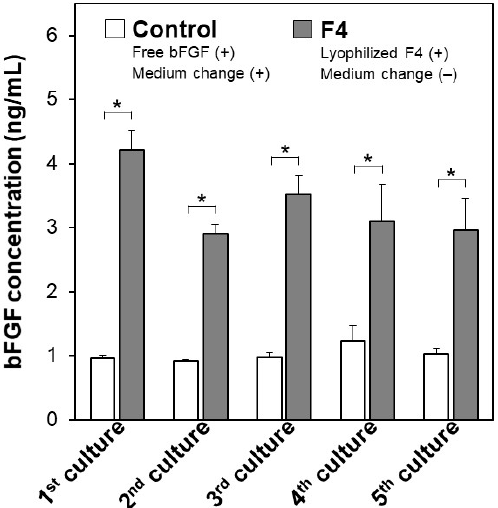
Figure 6. Concentrations of bFGF in the culture medium of human iPSCs, on Day 3 in repeated (up to 5 times) cycles of the medium-change-free continuous culture with the lyophilized F4 membrane (F4 group; gray bars) or of standard culture using bFGF-containing medium with daily medium refreshment (control group; white bars) (average + SD; n = 3; * p < 0.05).